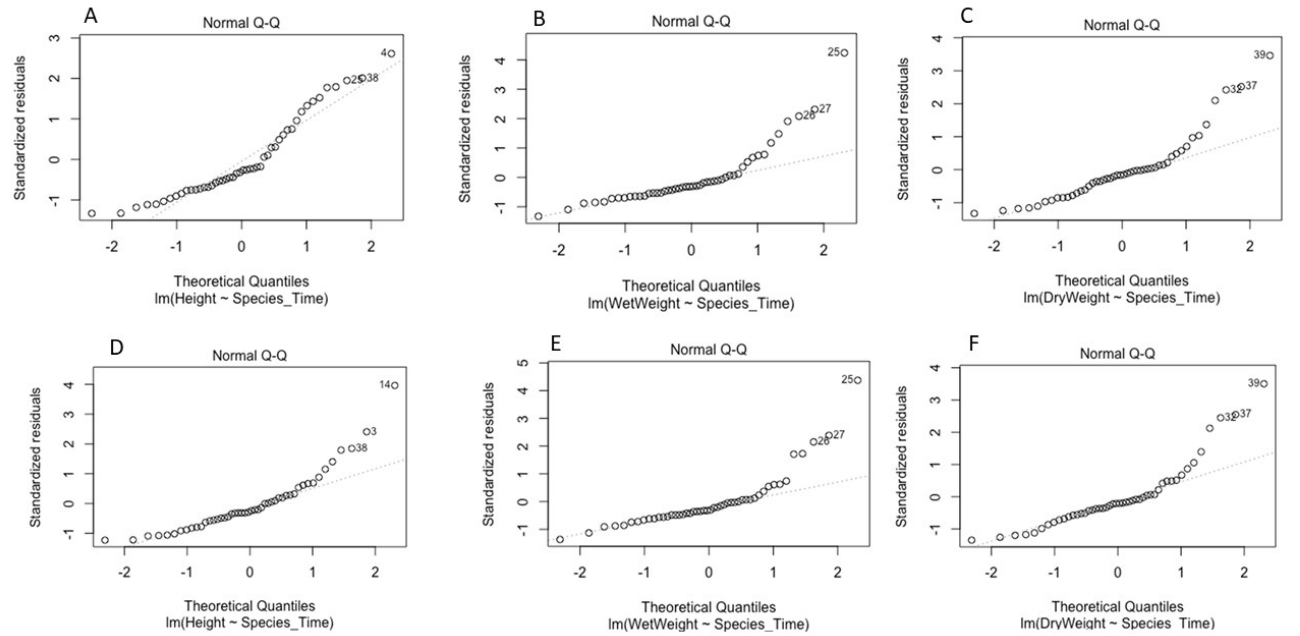
Figure 7. Model validation for Phytophthora cryptogea and P. cactorum plant inoculation: ( A – C ) Q-Q plot of standardized residuals against fitted values of the model of P. cryptogea plants inoculation of the response variables plant height, fresh weight and dry weight; ( D – F ) Q-Q plot of standardized residuals against fitted values of the model of P. cactorum plants inoculation of the response variables plant height, fresh weight and dry weight.